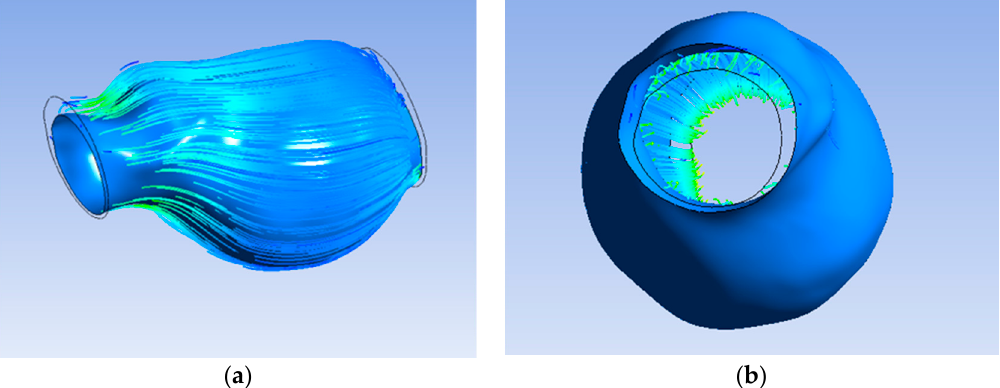
Figure 7. ( a ) Streamline penetrating ILT surface; ( b ) streamline only inside ILT.